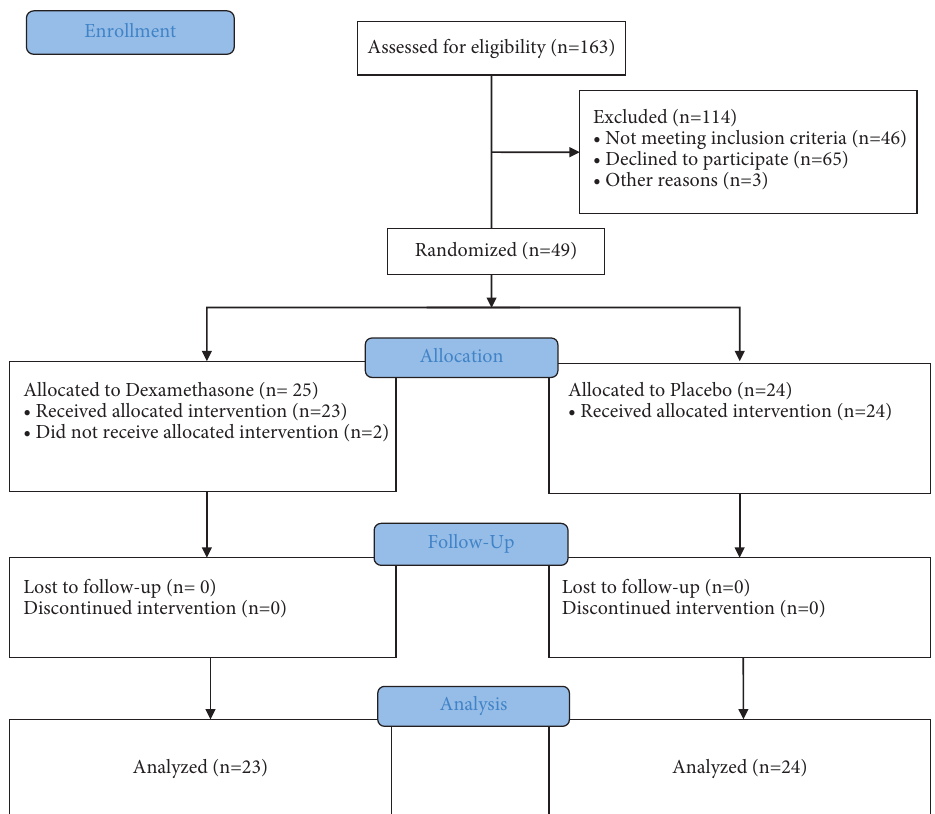
Figure 1: Consort 2010 flow diagram: prospective, double-blind, randomized, placebo-controlled trial of intravenous dexamethasone vs. placebo for postcesarean delivery